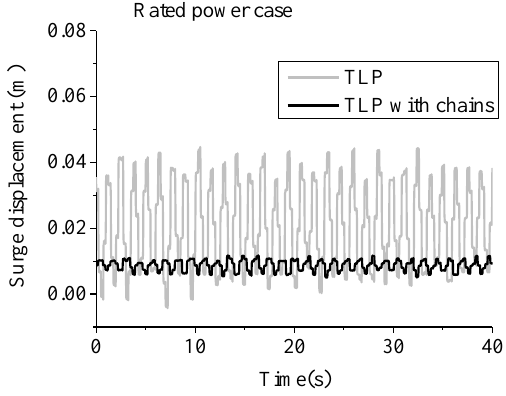
Figure 5. The comparison of the two FOWT’s surge responses under rated power case.